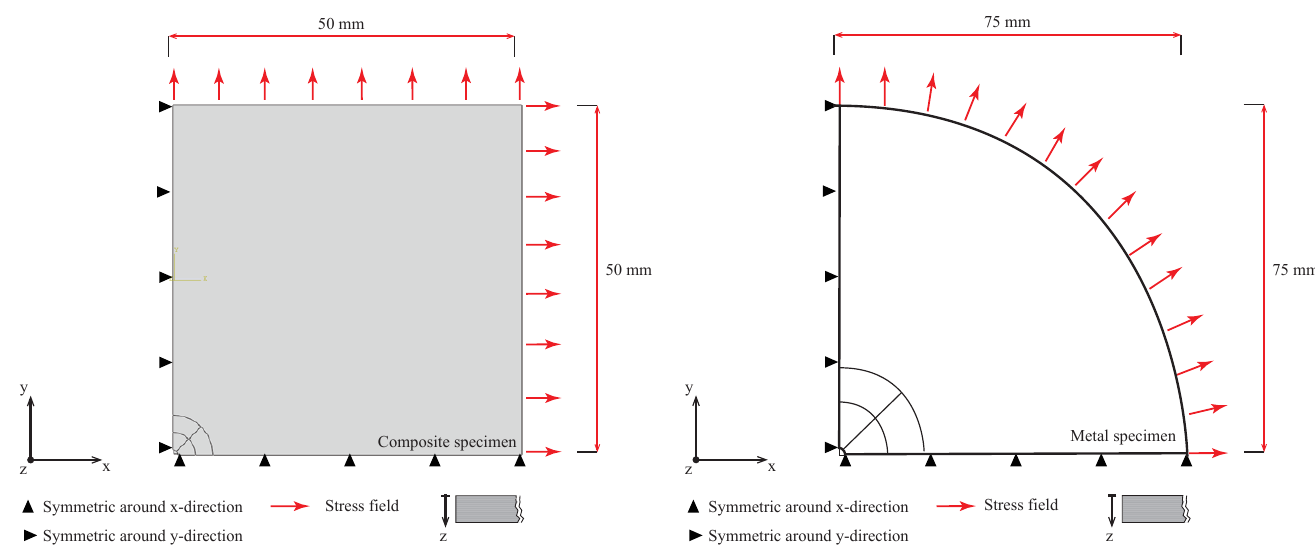
Figure 4. External load